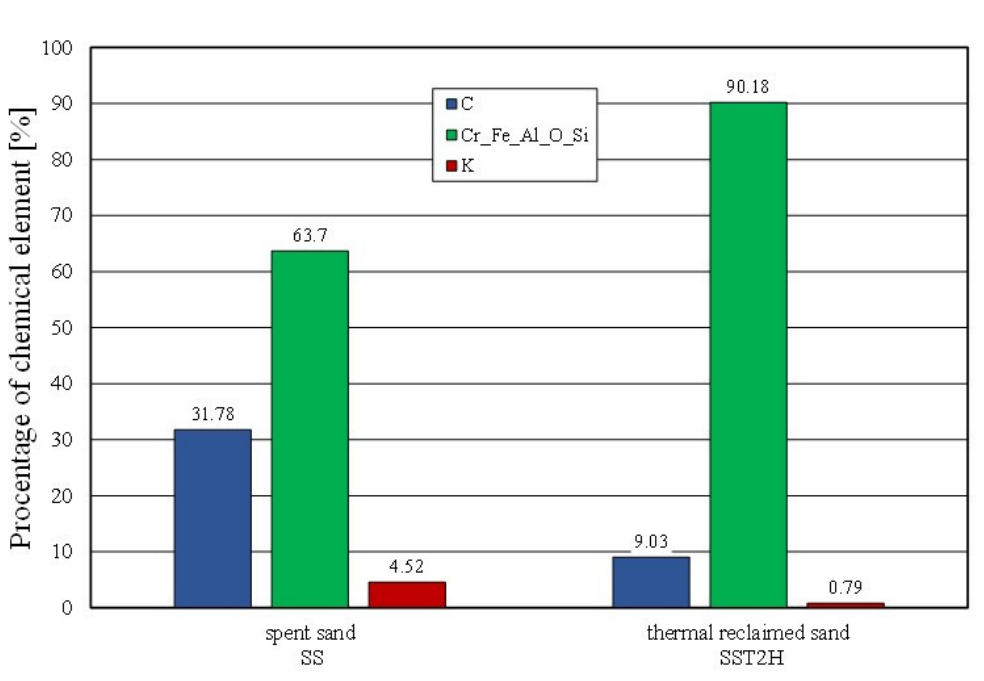
Figure 17. Comparison of chemical composition of spent sand and grain matrix after thermal reclamation.